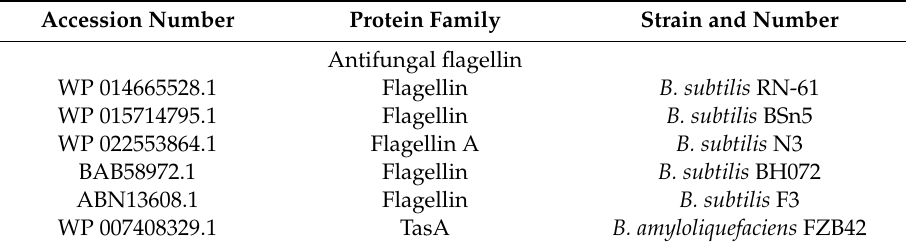
Table 2. Antifungal disease-related